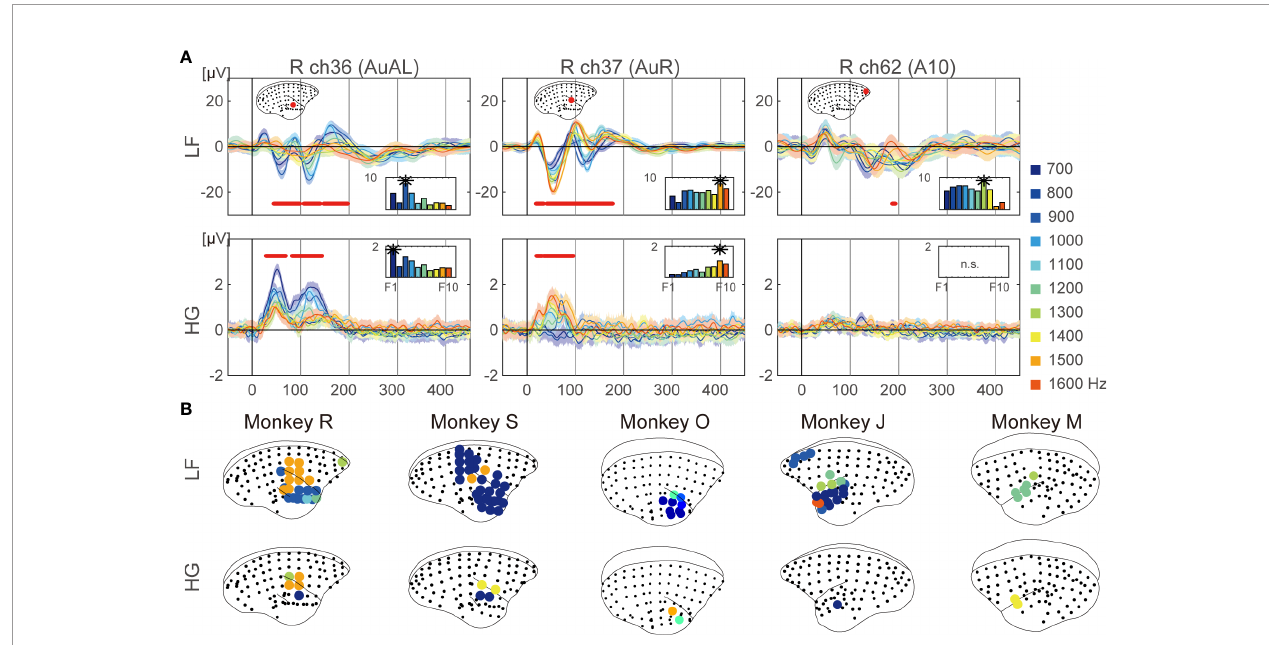
FIGURE 2 | Frequency preference. (A) Examples of representative ECoG responses to each frequency at selective electrodes of monkey R. Mean responses to each 10 frequencies are represented. The shaded areas correspond to 95% con fi dence intervals. The red dots represent time points which showed signi fi cant different responses to frequencies. The bar plot represents the mean responses to each frequency over time which were signi fi cant. The best frequencies of the electrodes are represented as asterisks. (B) Cortical maps of the tonotopy of LF (top insets) and HG (bottom insets). The circles indicate electrodes which show statistical signi fi cance, with colors representing the best